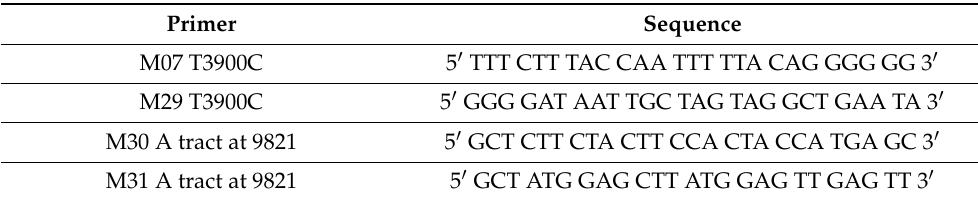
Table 3. Primers (IDT, Coralville, IA,